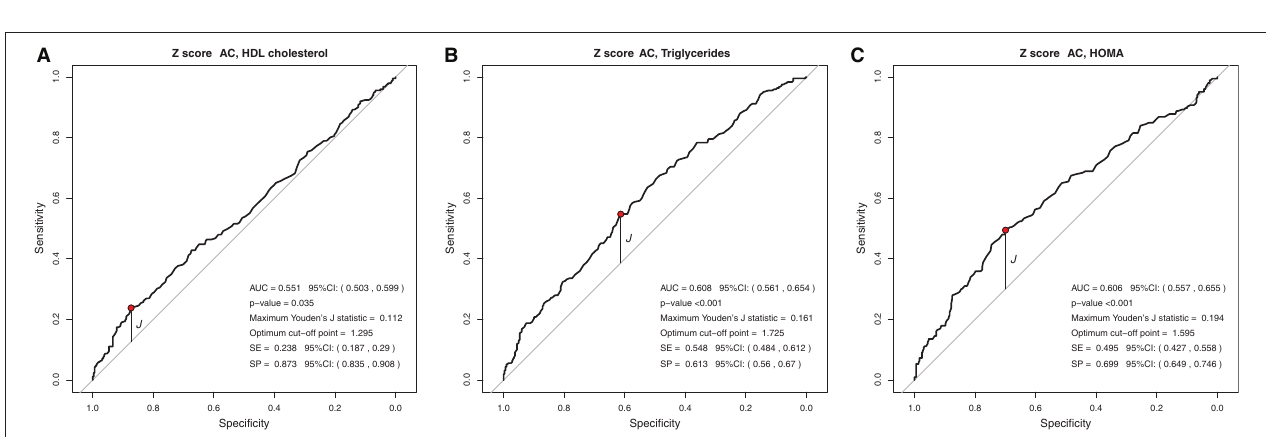
FIGURE 2 | (A–C) Suggested cut-off points for a WC z-score, with greater ability to rule out changes in HDL-c, TG, and HOMA-IR levels.